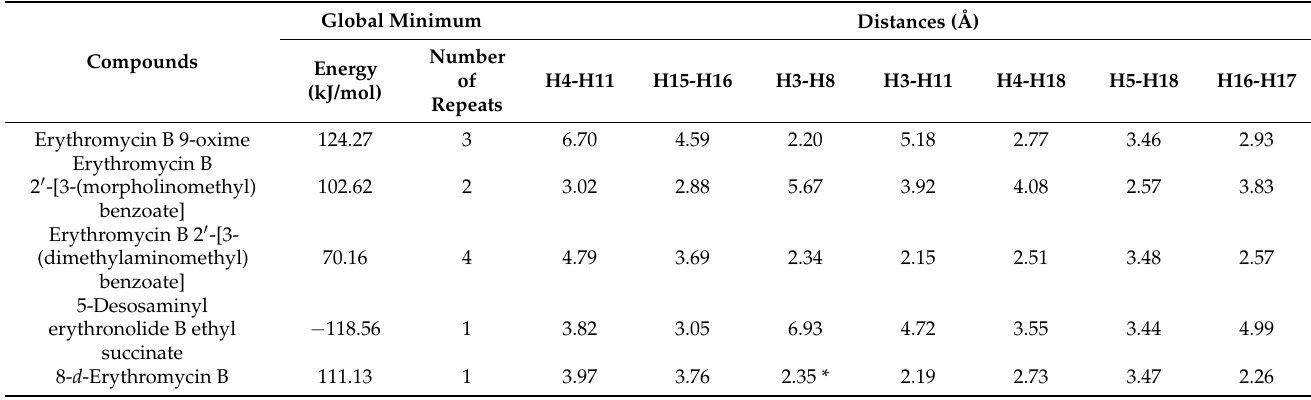
Table 1. Distances (Å) for the selected contacts of the global minima obtained in the unconstrained conformational search for selected derivatives of erythromycin B, and energies of global minima and times they repeat.